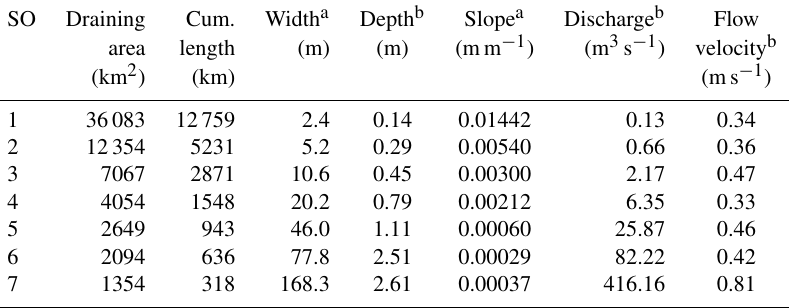
Table 1. Hydro-morphological characteristics of the Seine drainage network, a averaged by Strahler order (SO) and b over the time period 2010-2013. Hydrographic network provided by the Agence de l’Eau Seine Normandie and water discharges by the national Banque Hydro database. Depth and flow velocity calculated according to Billen et al. (1994); width calculated according to Thieu et al. (2009). SO Draining Cum. Width